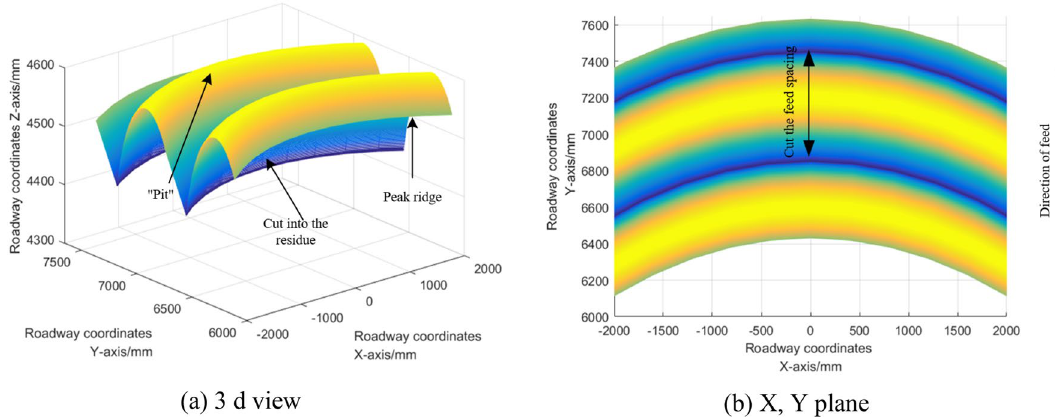
Figure 5. Simulation results of roadway surface morphology.